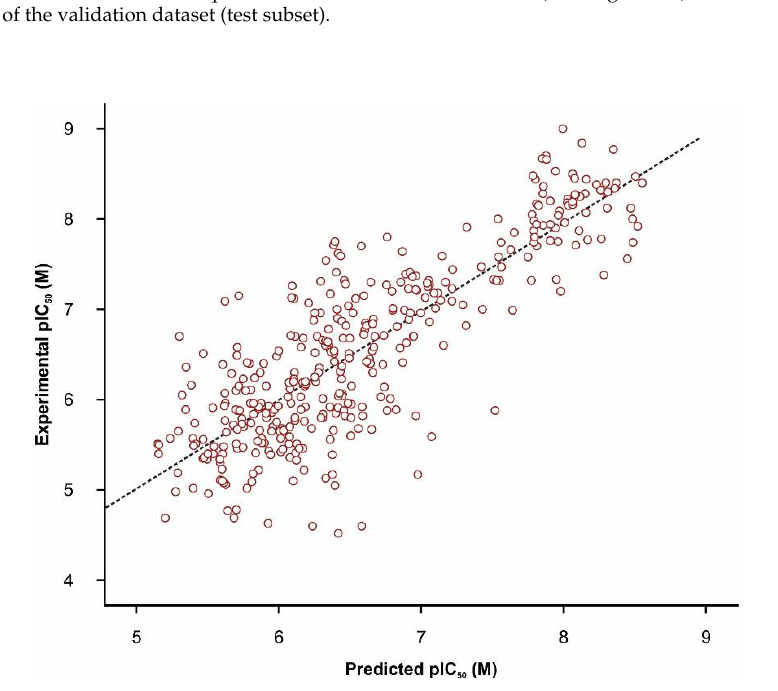
R 2 —squared correlation coe ffi cient of the training subset: R 2 pred —squared correlation coe ffi cient of the predicted (test) subset; RMSEC—Root Mean Square Error of the calibration dataset (training subset); RMSEV—Root Mean Square Error of the validation dataset (test subset).